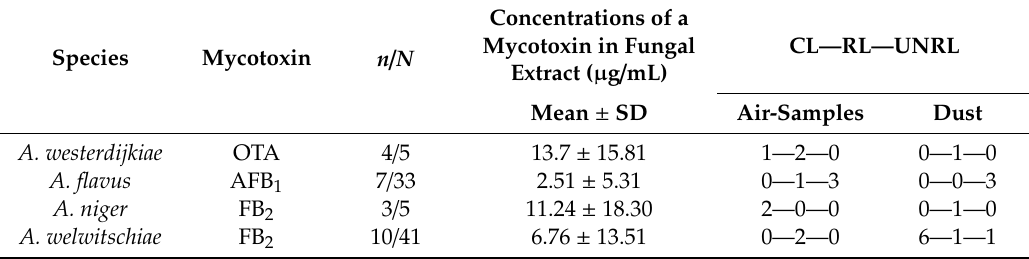
Table 1. Mycotoxin-producing abilities of the species assigned to the sections Circumdati, Flavi, and Nigri, and the distribution of mycotoxin-producing isolates over control and post-flood locations.